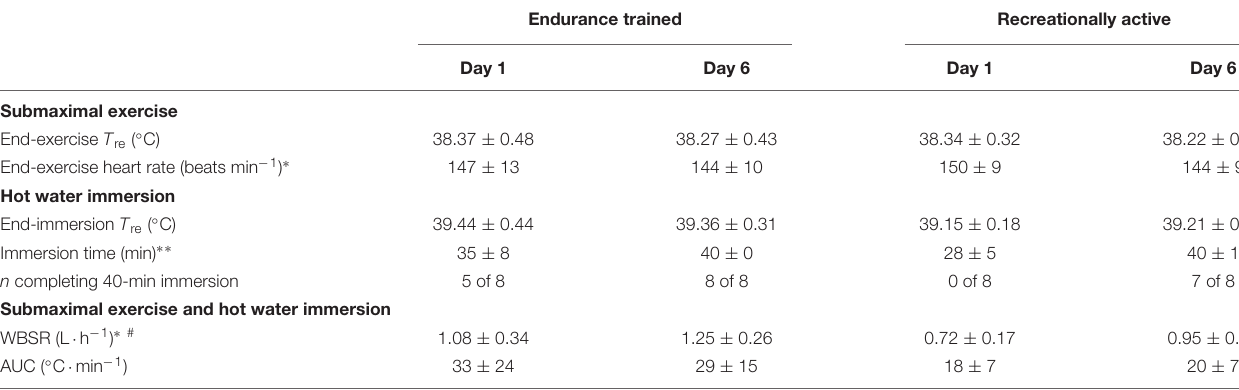
TABLE 1 | The influence of 40-min submaximal running at 65% ˙ VO 2max in temperate conditions followed by post-exercise hot water immersion in 40 ◦ C water on thermoregulatory variables, heart rate and immersion time in endurance trained and recreationally active participants. Endurance